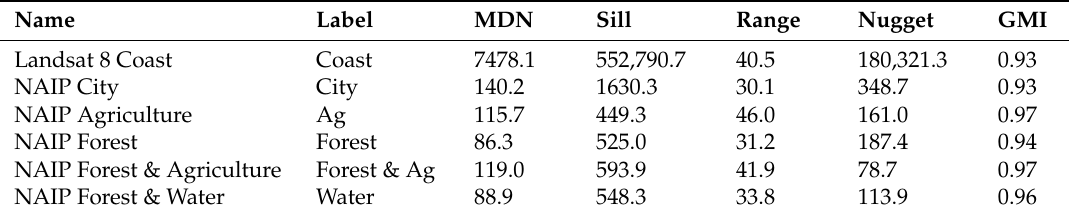
Figure 2. Base images used in simulations. Zoomed-in areas illustrate the extent for which images were subset and summarized to estimate mean digital number, sill, nugget, and range values. Table 1. Average digital number (MDN), sill, nugget, and global Moran’s index (GMI) and maximum range (in number of cells) values for Landsat and National Agriculture Imaging Program (NAIP) imagery. Averages and maximum values were based on all bands within an image.